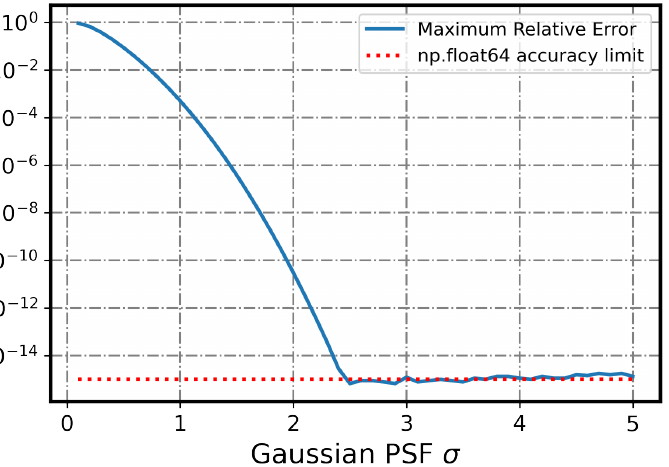
Figure 8. Error analysis about the PSF size and the sampling rate. The maximum relative error decreases rapidly to 10 − 15 as the PSF’s size